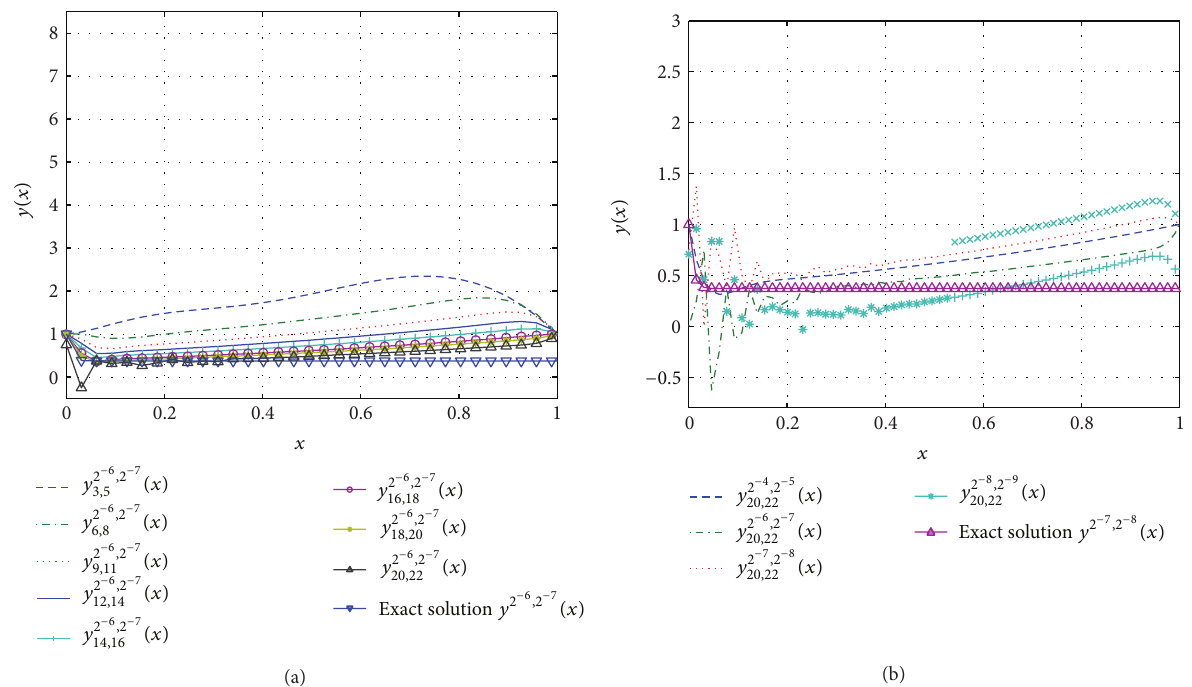
Figure 3: For (42), (a) comparison of the exact solution and the approximate solutions for 𝜀 = 2 −6 , 𝛿 = 0.5𝜀 , and various values of 𝑁 and 𝑀 and (b) comparison of the exact solution for 𝜀 = 2 −7 , and 𝛿 = 0.5𝜀 , and the approximate solutions for 𝜀 = 2 −4 , 2 −6 ,2 −7 , and 2 −8 , 𝛿 = 0.5𝜀 , 𝑁 = 20 , and 𝑀 = 22